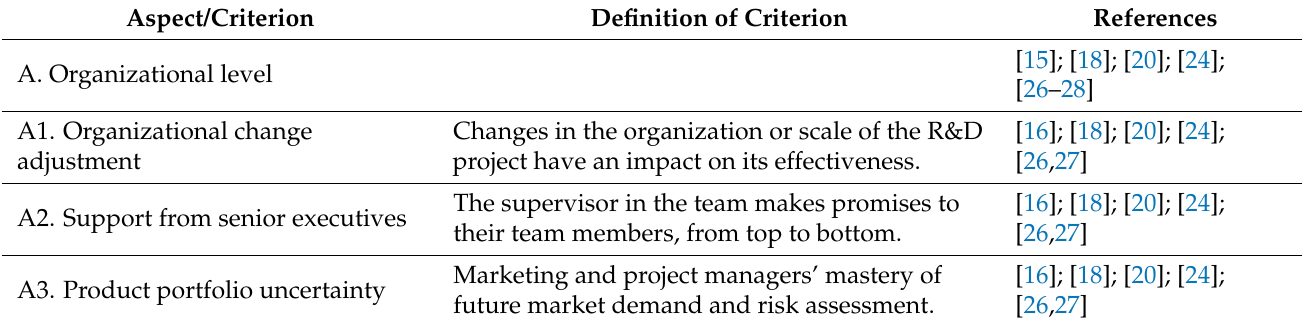
Table 1. Aspects and criteria of the preliminary